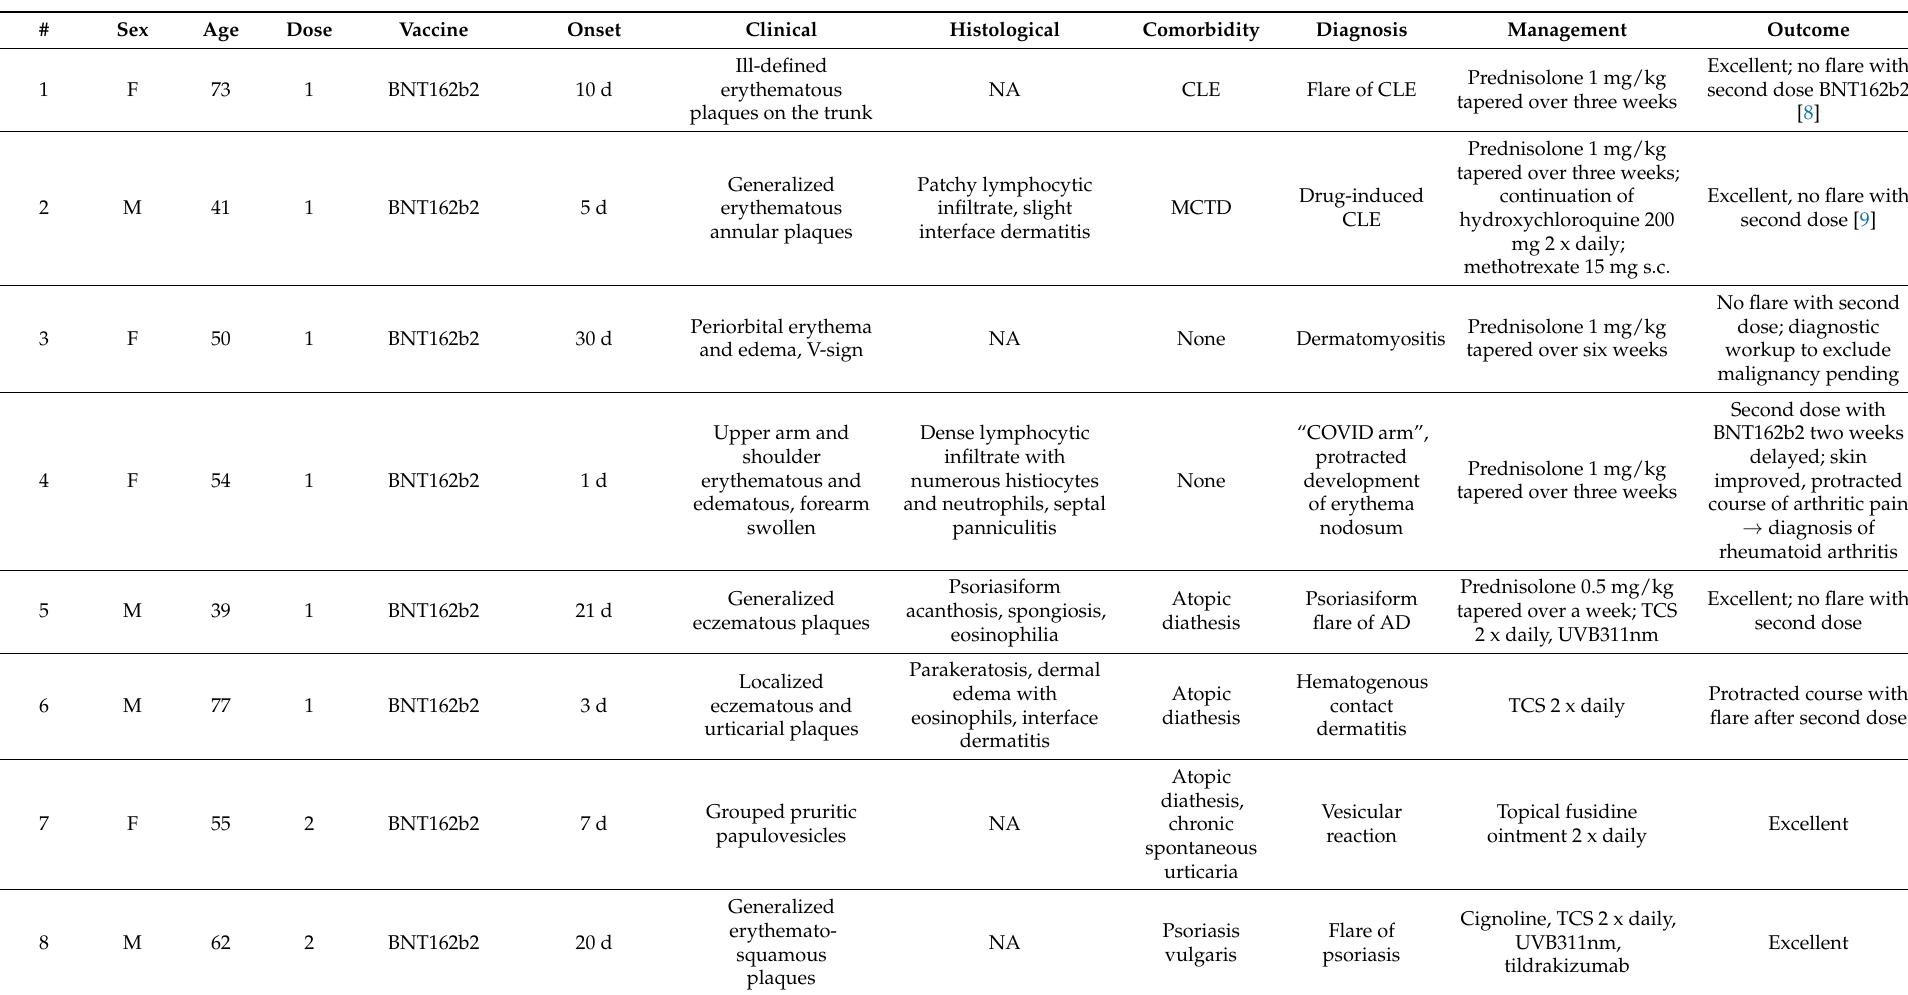
Table 1. Tabular overview of cutaneous adverse vaccine reactions of the Department of Dermatology and Allergy of the University Hospital Bonn from May until June 2021. Abbreviations: F—female; M—male; NA—not available; p.o.—per os; s.c.—subcutaneous; CLE—cutaneous lupus erythematosus; MCTD—mixed connective tissue disease; AD—atopic